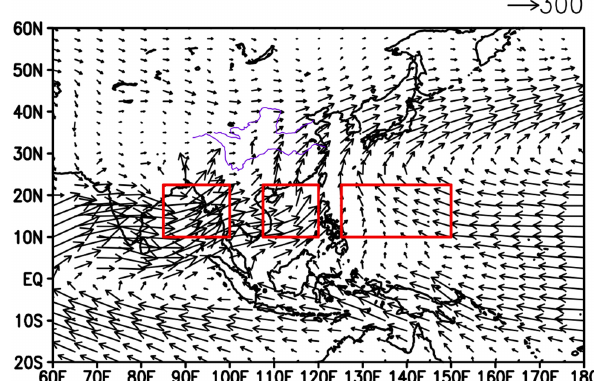
Figure 2. The climatological mean of summer (June-July-August) water vapor flux vectors vertically integrated from the surface to 300hPa from 1960 to 1994 (unit: kgcm − 1 s − 1 ); the three rectangles indicate the extents of the Bay of Bengal, the South China Sea, and the western North Pacific from left to right, successively.